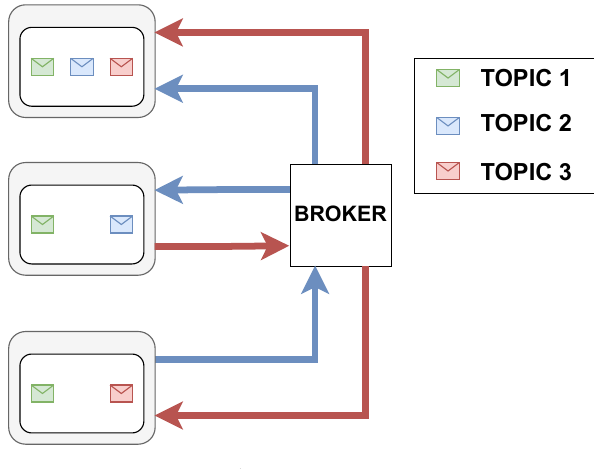
Figure 2. MQTT -SN scheme.